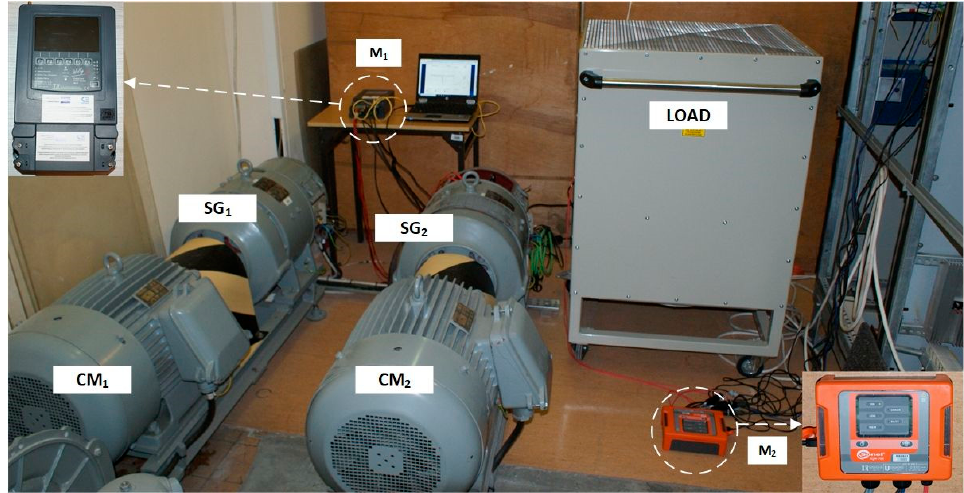
Figure 15. Laboratory stand: generating sets: CM 1 —SG 1 and CM 2 —SG 2 , RL load, and power quality meters: M 1 and M 2 (for the parameters of SG 1 and SG 2 ).